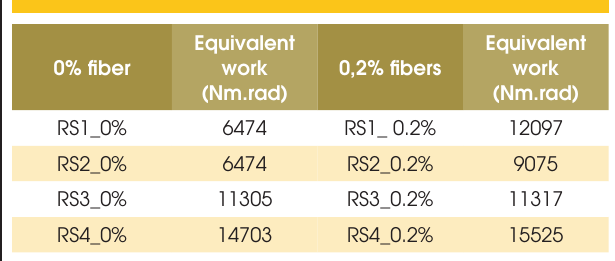
Table 3 – Equivalent work of mixtures according to torque vs. time integral